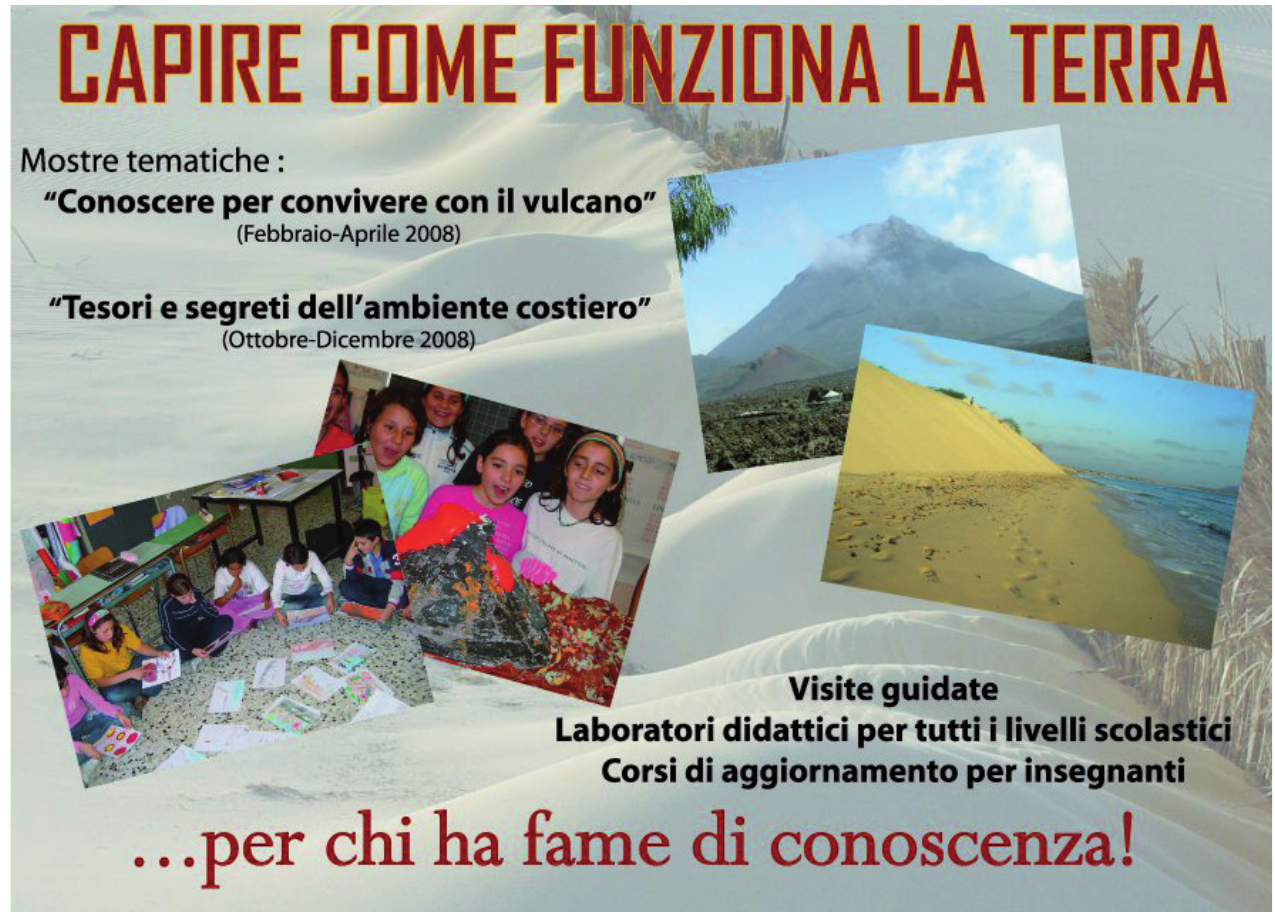
Figure 1. The exhibitions were promoted by flyers and